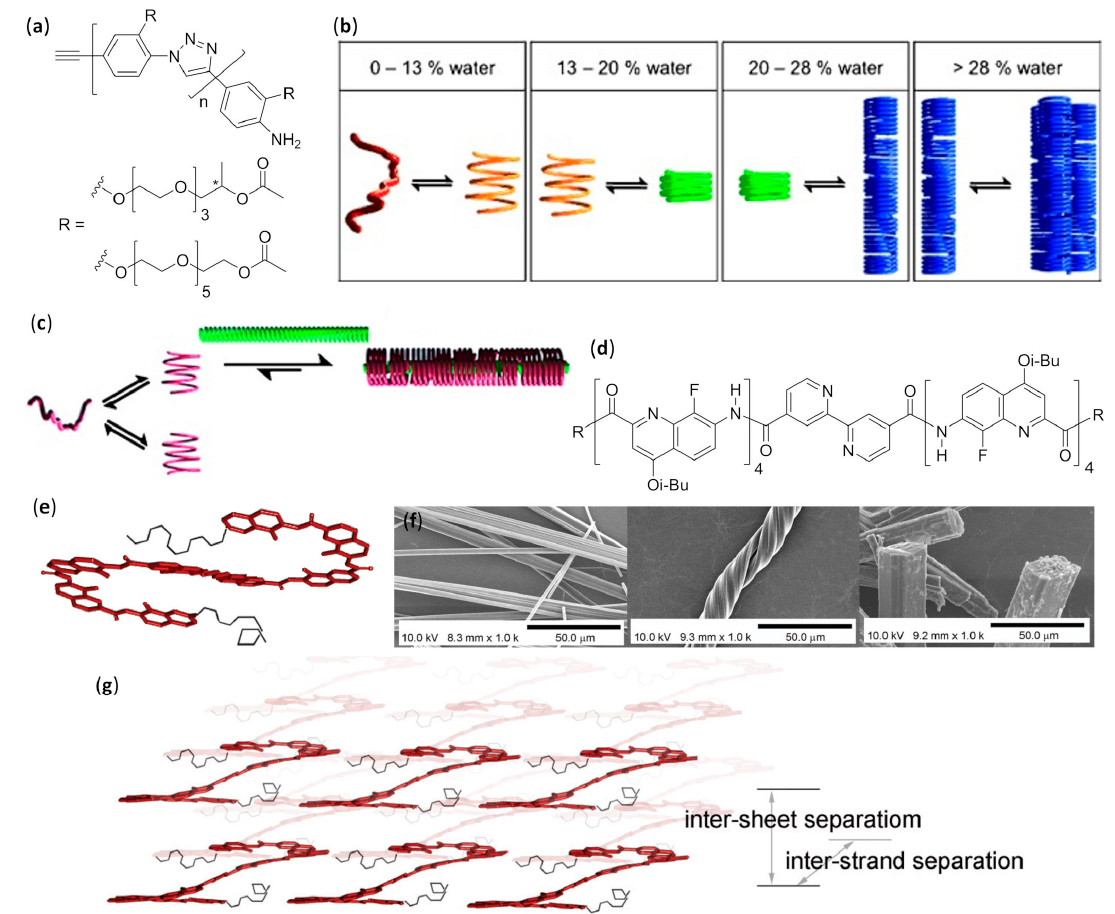
Figure 16. ( a ) Chemical structures of poly( p -AT)s (Ref. [181]); ( b ) Equilibria involved in the aqueous hierarchical self-assembly of poly( p -AT)s as the water content increases (random coil in red, loose spring in yellow, helix in green, nanotube and bundle in blue) (reprinted with permission from Ref. [181]); ( c ) Diastereoselective formation of host–guest nanotubes by interaction of achiral poly( p -AT) (purple) with the rigid α -helix of poly( γ -benzyl-L-glutamate) (green) (reprinted with permission from Ref. [181]); ( d ) Chemical structure of 8-fluoroquinolinecarboxamide and bipyridyl-based oligomers (Refs [154,182]) and ( e ) their S-shaped folding (backbone in red sticks; terminal alkyl chains in black wireframe) (adapted with permission from Ref. [182]); ( f ) SEM images of structures formed by foldamers with R = NHC 6 H 13 (hollow tubes, left), NHC 12 H 25 (twisted fibers made of hollow fibrils, middle), and NHC 18 H 37 (rods, right) (adapted with permission from Ref. [182]); ( g ) Common packing mode of different S-shaped foldamers giving the morphologies in panel ( f ) (adapted with permission from Ref. [182]).